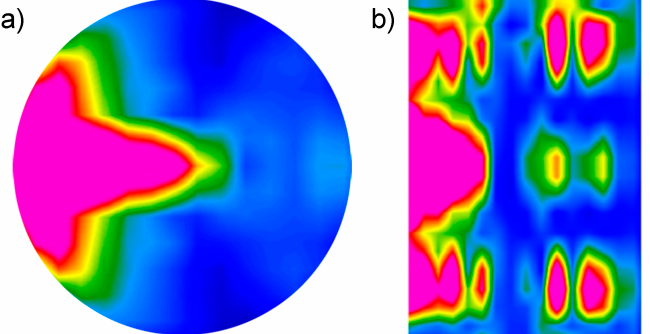
Figure 8. Distribution of average bulk density of power losses within MSS-2 reactor filled with water in the xy plane ( a ), and in ( b ) the xy section. Pink area shows more intense losses.